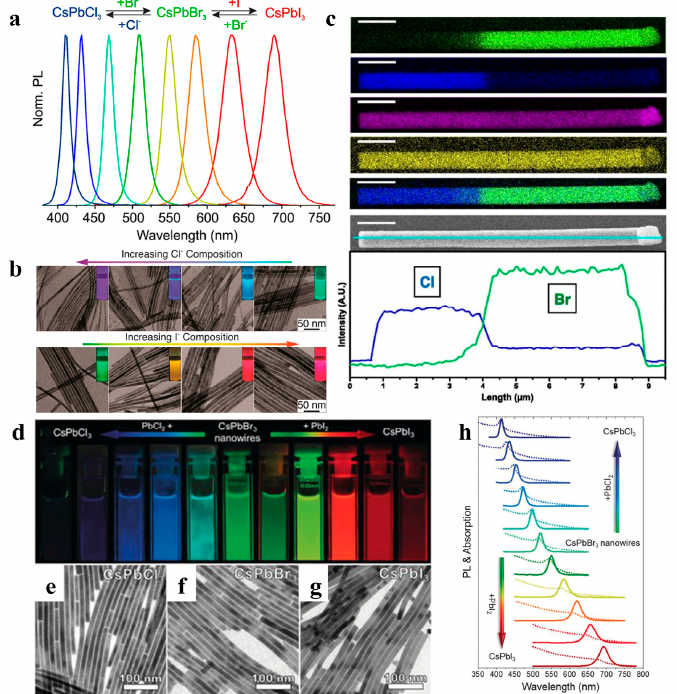
Figure 9. ( a ) PL spectra of the anion exchange reaction in the CsPbX 3 NCs system. Reproduced with permission from reference [86]. Copyright 2015, American Chemical Society. ( b ) TEM